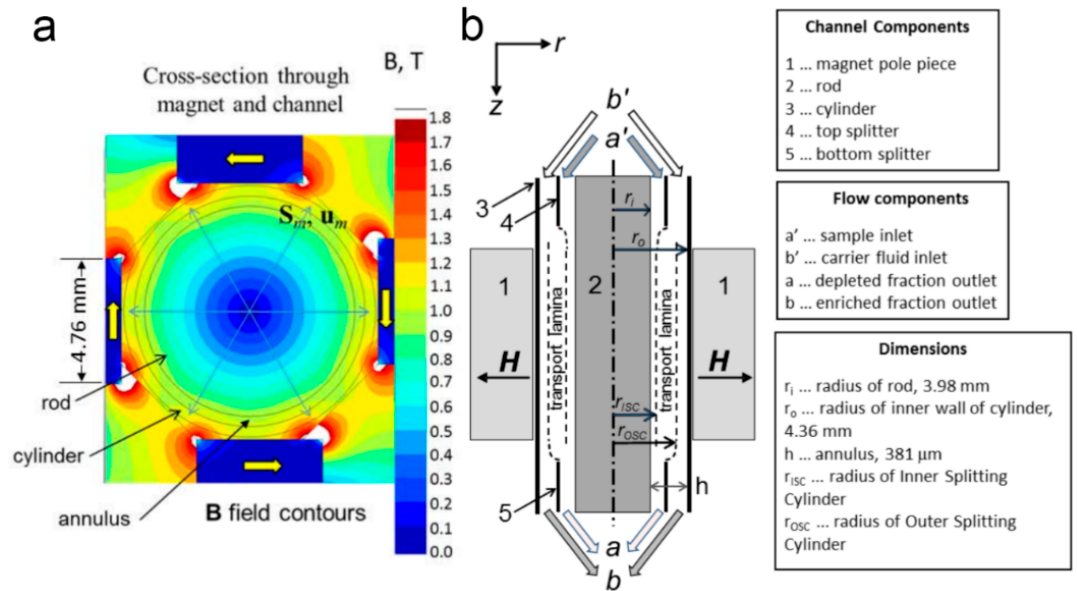
Figure 13. ( a ) Cross-sectional field map of the magnetic field of a quadrupole magnetic flow sorting (QMS) magent; ( b ) axial section diagram of the separation column contained within the quadrupole magnet assembly. Reprinted with permission from [231] . Copyright 2018, John Wiley and Sons.